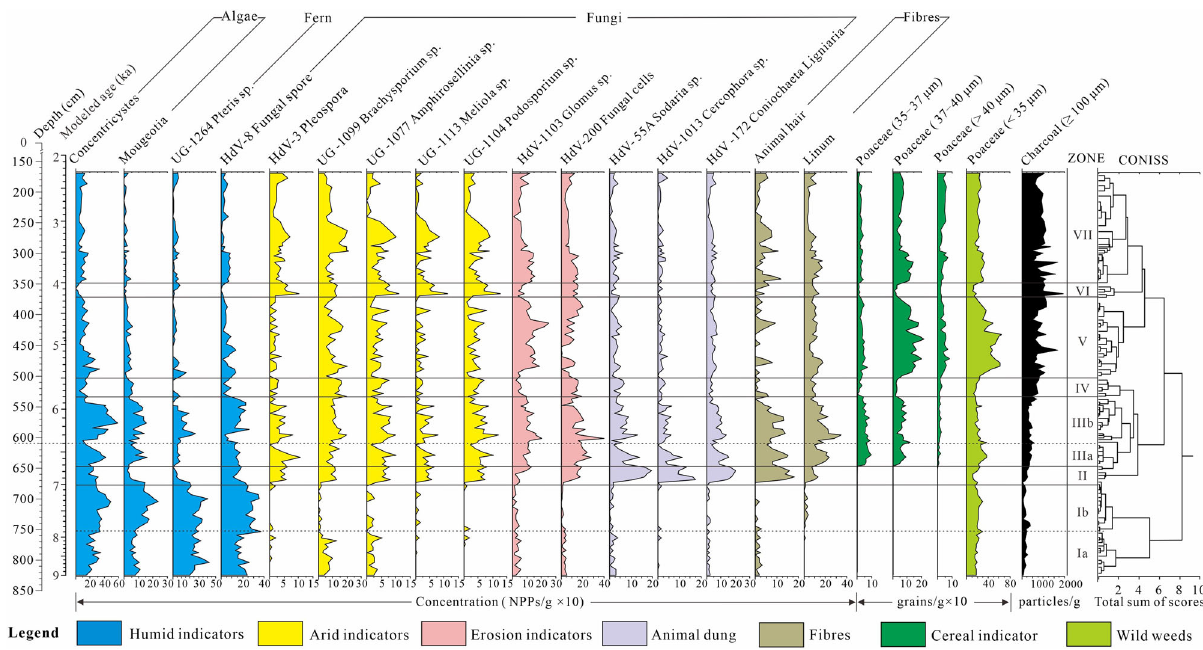
Fig. 3 NPP pollen spectrum of SH-1. Seven (7) indicators identify the signatures of the Holocene environmental change in the Nile Delta. Animal dung and fi bres appear noticeably in Zone II (7 ka), and the classi fi ed Poaceae (35 – 37; 37 – 40; >40 µ m) representing domesticated cereal appear fi rst in Zone III (6.7 ka), indicating that herding predates farming at the site. Increasing charcoal (>100 µ m) indicates the use of fi res in cropping-base farming. The little correlated relationship between wild Poaceae (<35 µ m) and classi fi ed Poaceae indicates domesticated cereal imported from outside. Poaceae <35 µ m and charcoal >100 µ m was cited from our previous study 37